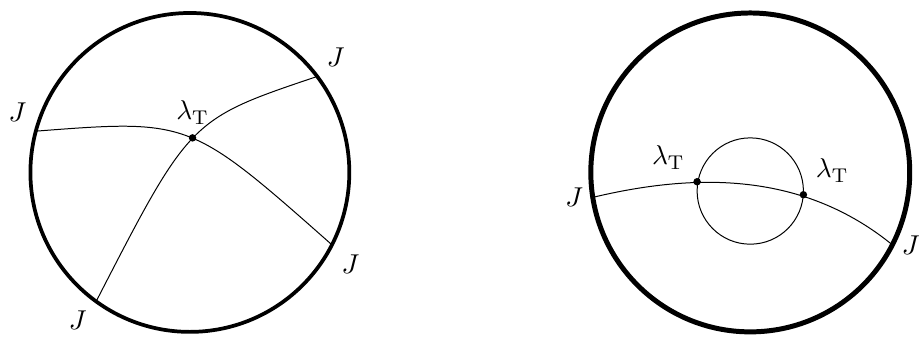
Figure 7 . Two infinite families of diagrams contributing to the line defect g -function. Their contributions are related by a factor of two as a consequence of the Schwinger-Dyson